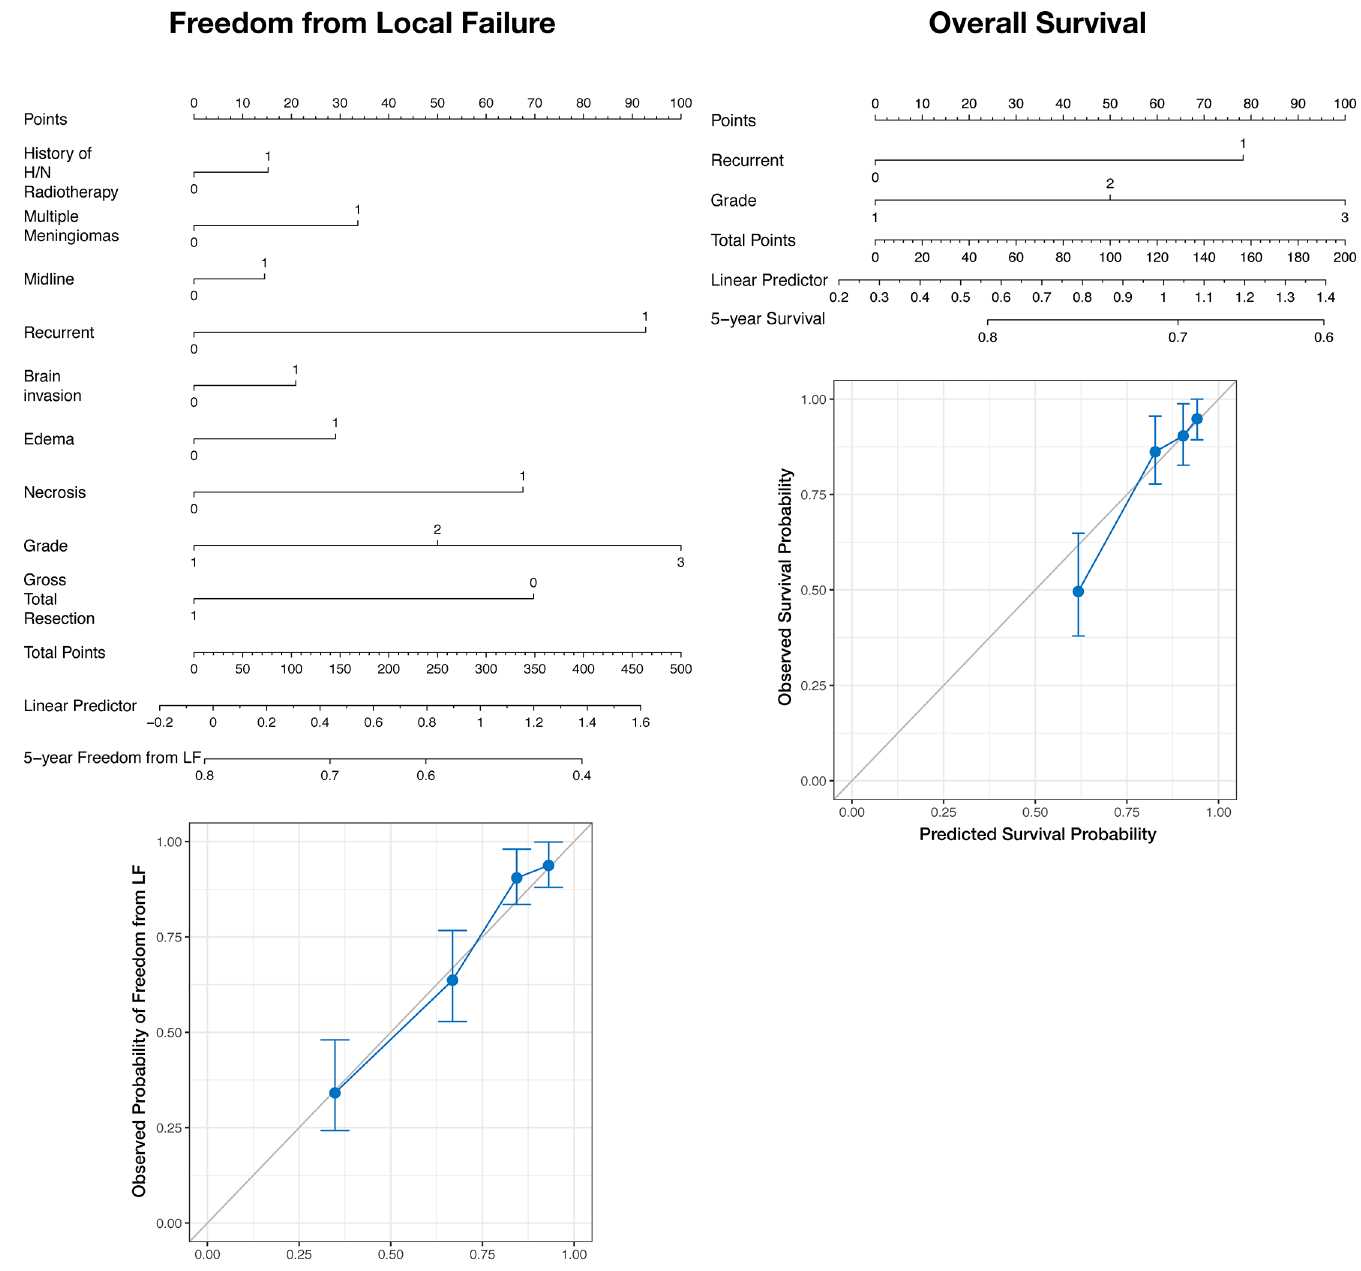
Fig 5. Machine learning nomograms for meningioma outcomes. Nomograms built using a penalized Cox model (adaptive elastic net) to predict 5-year freedom from LF (left) and 5-year survival (right) on the full sample. This procedure provides accurate survival estimates even in the presence of correlated features, which are not allowed in the original Cox regression model. Scatter plots show observed versus predicted probabilities obtained by training on 100 bootstrap samples and testing on the left-out set.